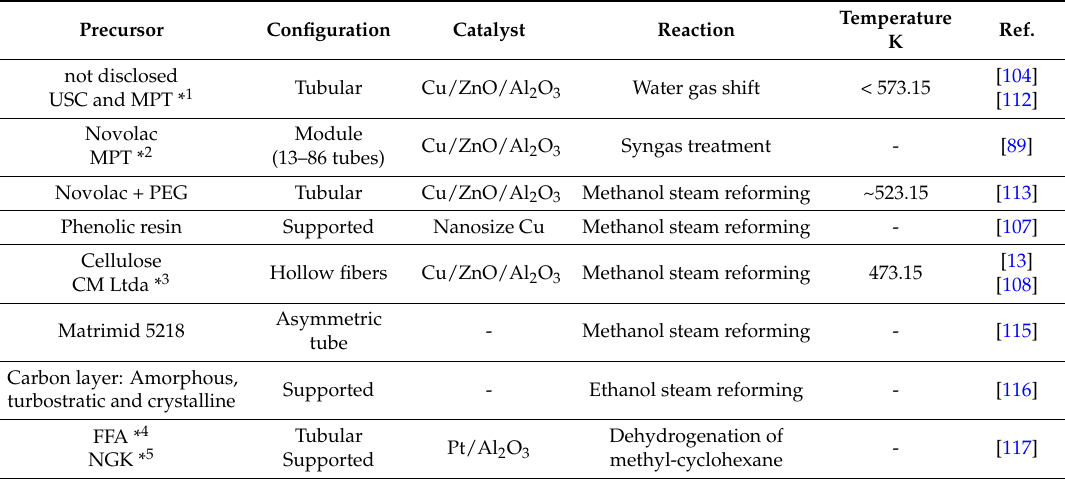
Table 3. List of carbon molecular sieve membrane